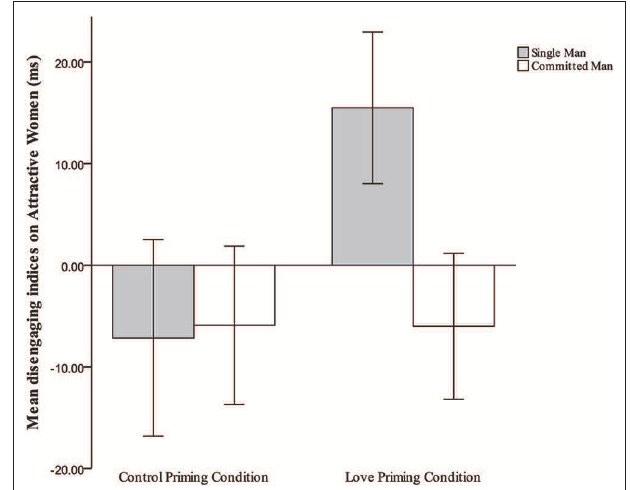
FIGURE 2 | Mean indices of disengagement from all target types for single men in the love priming and control priming conditions.